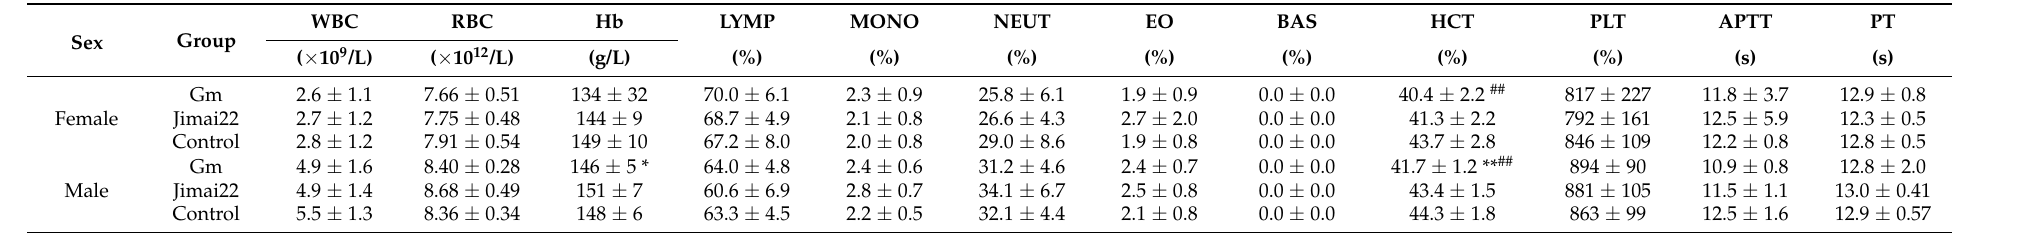
Table 1. Hematological parameters of male and female rats ( x ± s, n = 20).